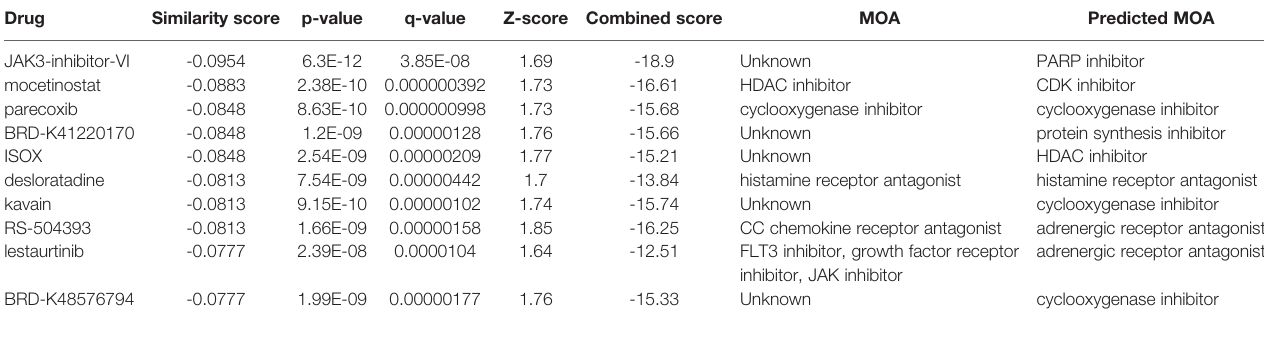
TABLE 2 | The screened drugs for PAAD treatment.